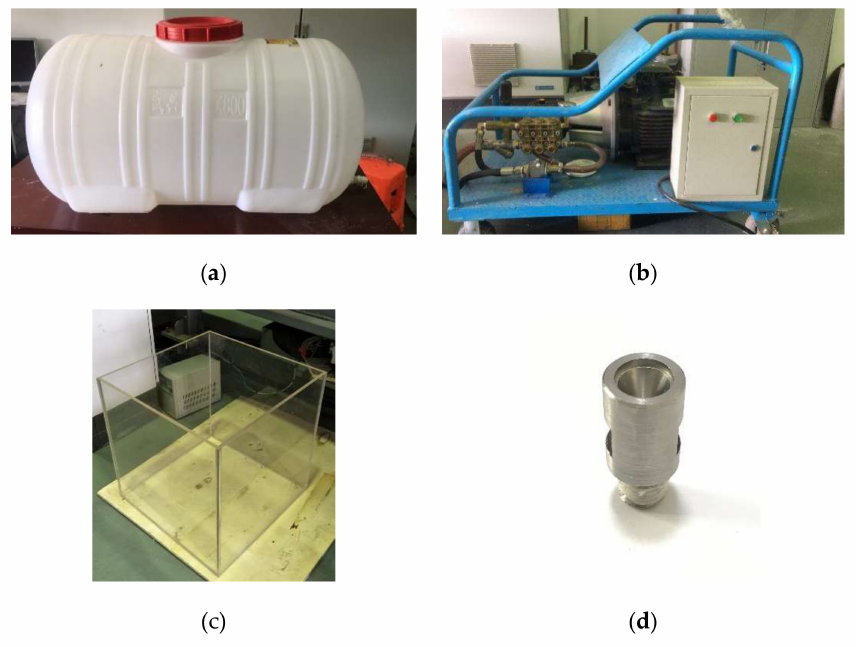
Figure 2. Experimental equipment. ( a ) Storage water tank, ( b ) high-pressure pump, ( c ) operating water tank, ( d ) angle